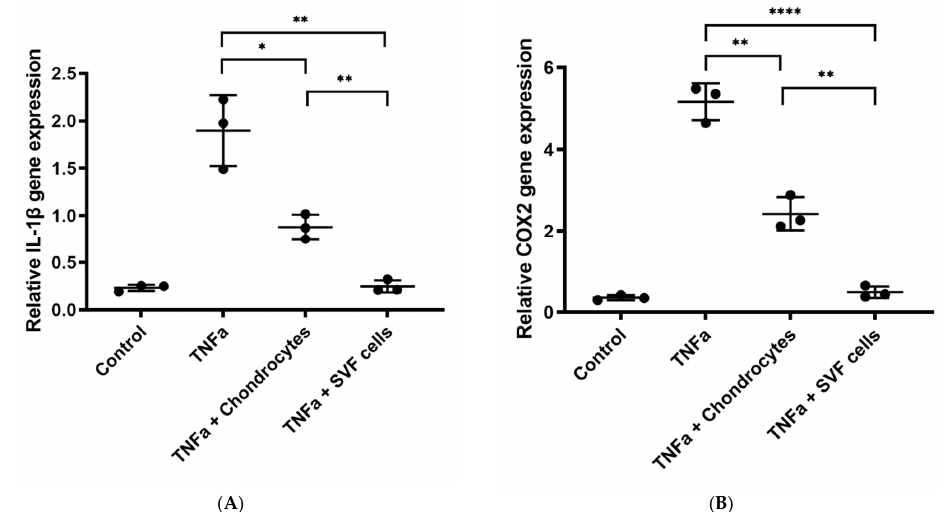
Figure 7. ( A ) Relative gene expression of interleukin (IL)-1 β ( A ) and cyclooxygenase 2 (COX2 (prostaglandin-endoperoxide synthase 2 (PTGS2)), ( B ) by tumor necrosis factor alpha (TNF α )-stimulated chondrocytes and subsequently treated with chondrocytes or tissue-like stromal vascular fraction (tSVF) cells for 24h. Results are expressed as mean ± SD and analysed with an unpaired t-test. * p ≤ 0.05. ** p ≤ 0.01. **** p ≤ 0.0001. Control = chondrocytes without TNF α treatment.